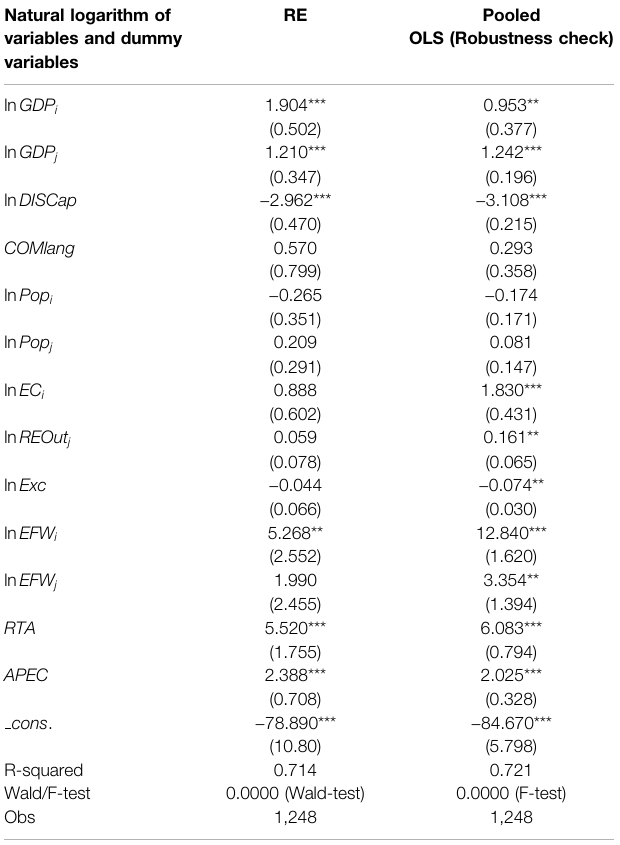
TABLE 3 | Estimated results for the sum of solar PV and WETC